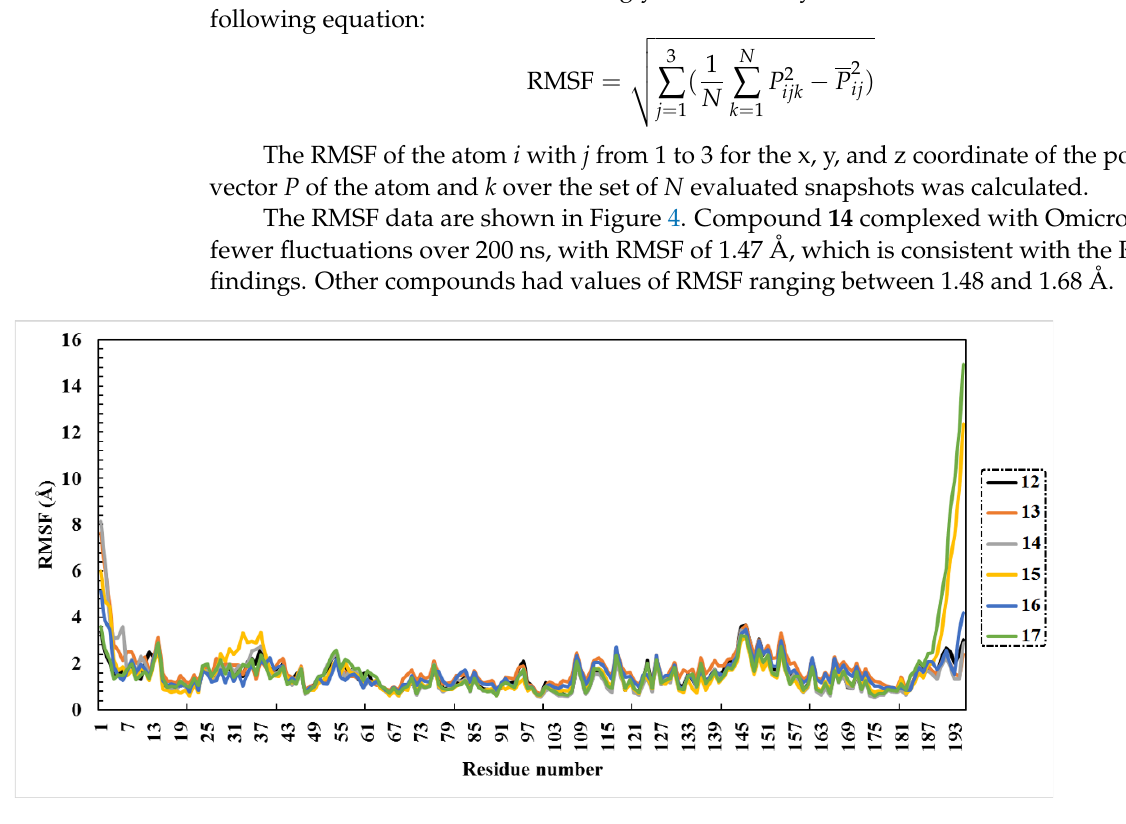
Figure 5. Radius of gyration (Rg) plot of six identified complexes through 200 ns MD simulations. Solvent-accessible surface area analysis (SASA) was performed to represent the area of protein exposed to solvent. The averaged SASA values of the six structures were 10,501, 10,428, 106,30, 11,007, 10,553, and 10,886 for compounds 12 to 17 , respectively. Despite the compact folding of 7QNW, the increase in SASA in compound 15 compared to the other compounds indicated obvious conformational changes due to ligand binding. Conse- quently, SASA may provide details about the protein ’ s ability to interact. As shown in the data in Figure 6, all six compounds exhibited relative stability and compactness over the course of the 200 ns MD simulation.